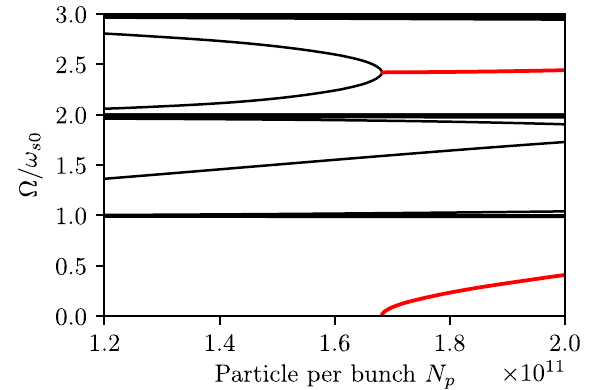
FIG. 13. Phase space of the most unstable mode for N p ¼ ¼ 0 . 12 computed with MELODY using the 2 . 0 × 10 11 and E max SPS impedance model from before LS2. The SPS parameters are according to Table I.